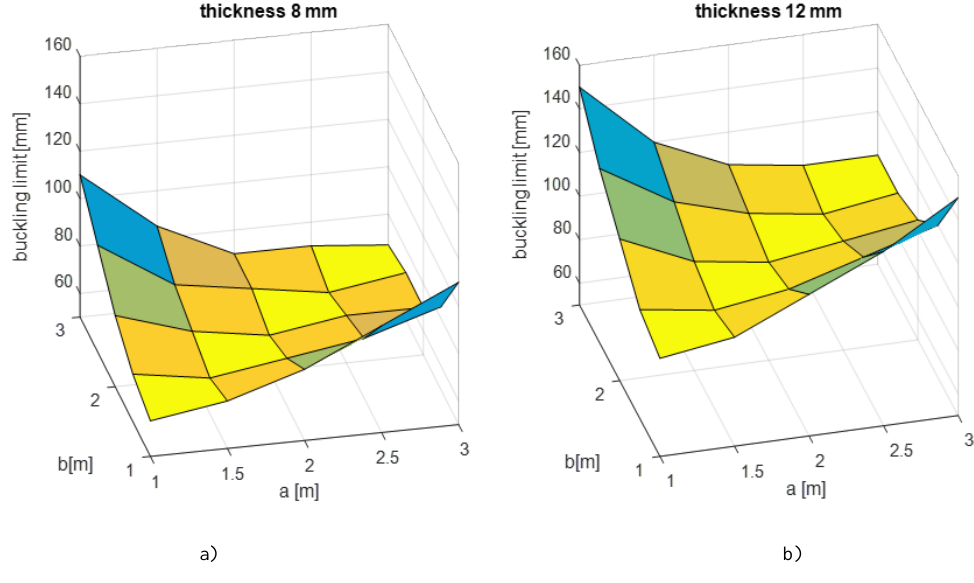
Fig. 5 Four-point supported glass plate. Buckling limit as a function of the plate edge length, for different plate thickness. It is evident that the buckling limit is higher for high values of aspect ratio λ = a/b (i.e., for rectangular plates) and, as expected, for high values of the plate thickness. Fig. 6 shows the buckling limit, plotted as a function of the glass thickness and of the aspect ratio λ = a/b , for different plate length a . These charts may be used as a practical tool for preliminary design of glass panels cold-bent into a hyperbolic paraboloidal